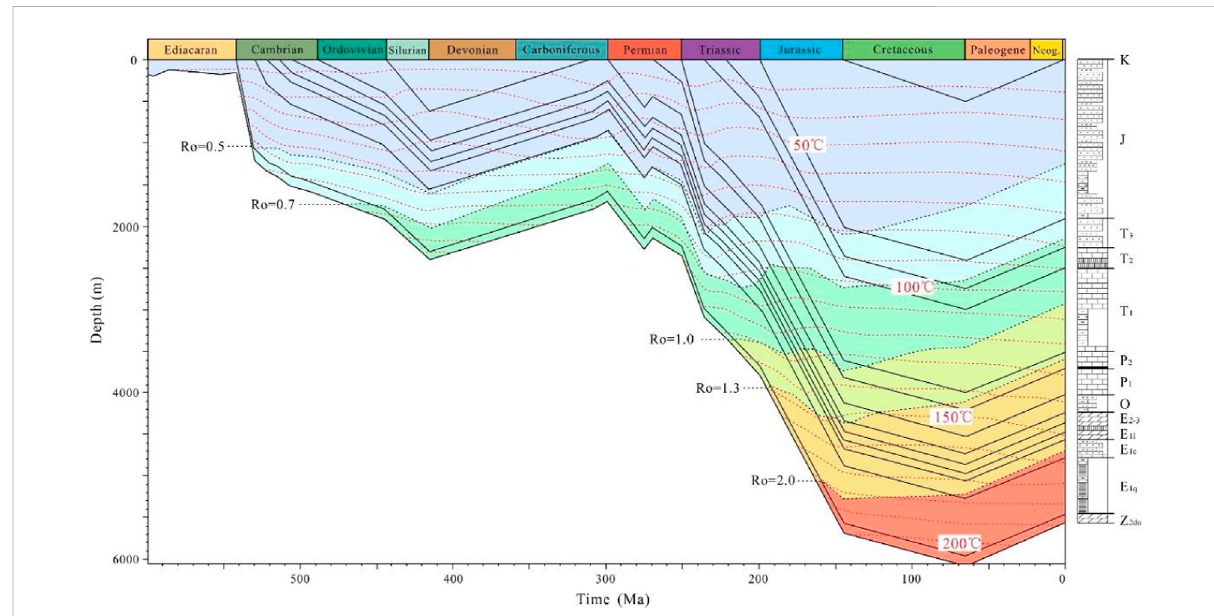
FIGURE 8 Hydrocarbon generation-evolution history of source rocks in Well